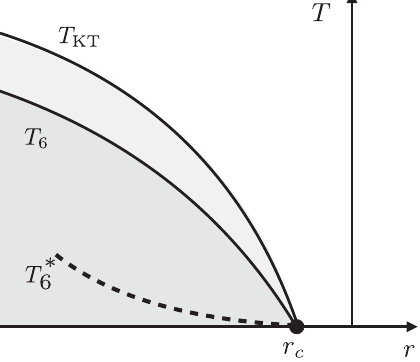
FIG. 2. Phase diagram of the structural instability of a planar ion crystal in the parameter space determined by the temperature T and the coefficient r , which is a function of the ratio K =C . The external line at T indicates the transition from a planar structure KT to a critical phase, where the ions are distributed along three layers and exhibit quasi-long-range order in the transverse direction. The second line at T 6 indicates the transition to a long-range ordered buckled phase, where the ions form three hexagonal lattices in the three layers, which are phase locked as shown in Fig. 1. The value r c < 0 indicates the critical point at T ¼ 0 . The dashed line at T (cid:2) 6 separates the quantum from the classical critical behaviors. See text for further